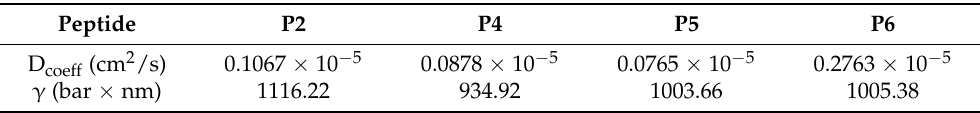
Table 3. The values of the diffusion coefficients of the peptide molecules in the water films and the surface tensions in the systems.